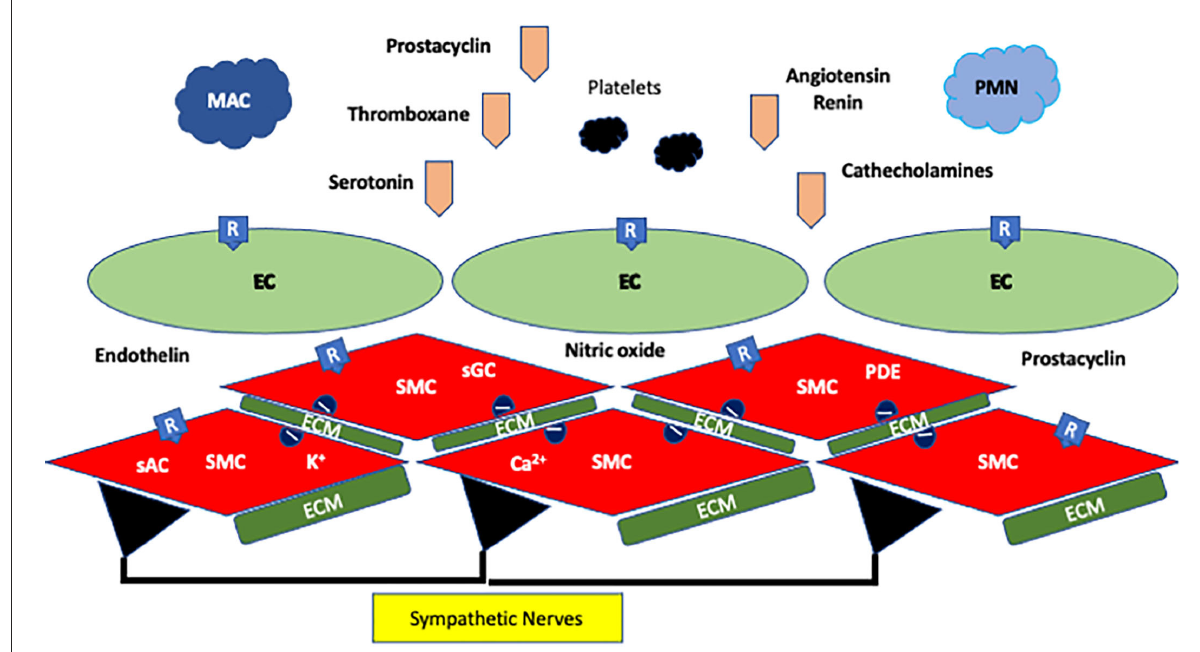
FIGURE2 Pathophysiology of pulmonary hypertension. The wall is composed of endothelial cells (EC) and vascular smooth muscle cells (SMC), and these cells sit in an environment of extracellular matrix (ECM). Both types of cells have ion channels for Ca 2 + and K + and receptors for prostaglandins (thromboxane and prostacyclin) and G-protein agonists (angiotensin, endothelin, serotonin, and catecholamines). In addition, nitric oxide from EC modulates SMCs. Soluble adenyl (sAC) and guanyl cyclases (sGC), and phosphodiesterases (PDE) modulate the ATP and GTP systems. EC and SMC are further influenced by sympathetic nerves in the wall. The combination of activation of EC and SMC, inflammation led by polymorphonucleocytes (PMN) and macrophages (MAC) coupled to progenitor cells, changes in the ECM, surges in or depletion of vasoactive factors and cytokines, altered receptor and ion channel expression, and overactivity of the sympathetic system led to pulmonary hypertension, vessel remodeling, myointimal hyperplasia, and occlusion in the pulmonary